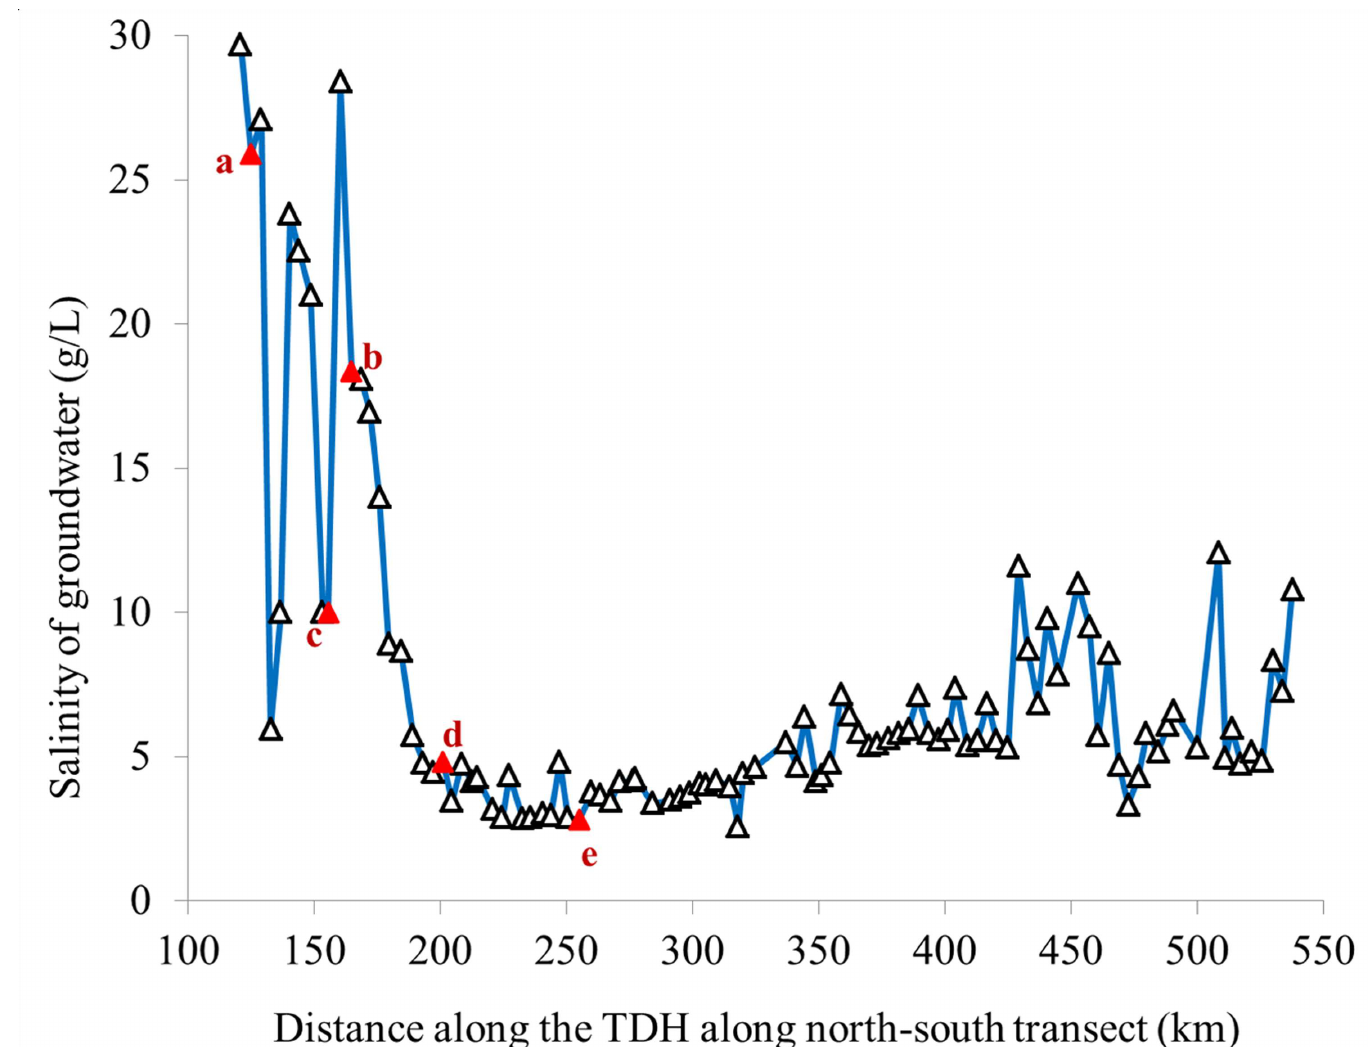
Fig 1. Distribution of salinity of groundwater used to irrigate the shelterbelt along the Taklimakan Desert Highway. Red triangles indicate the sites where soil samples were taken and analyzedfor salinity and water content, (a) 25.90 g/L, (b) 18.39 g/l, (c) 10.00 g/L, (d) 4.82 g/L, and (e) 2.82 g/L.